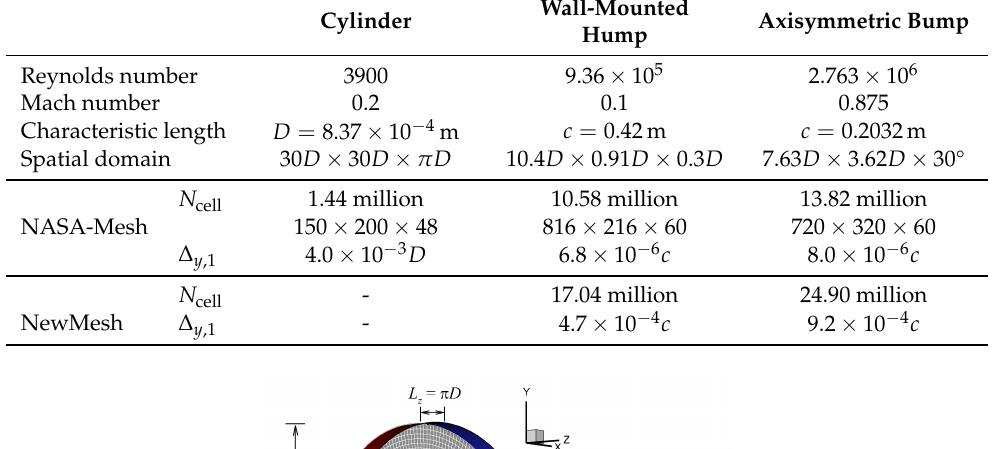
Table 1. Conditions for three flows.